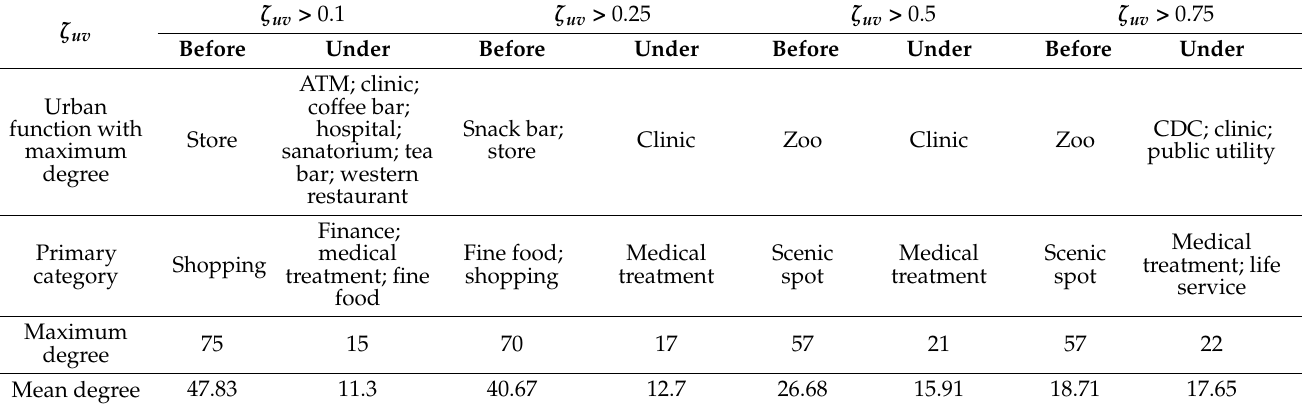
Table 4. Urban functions with negative interdependencies before and under the lockdown of